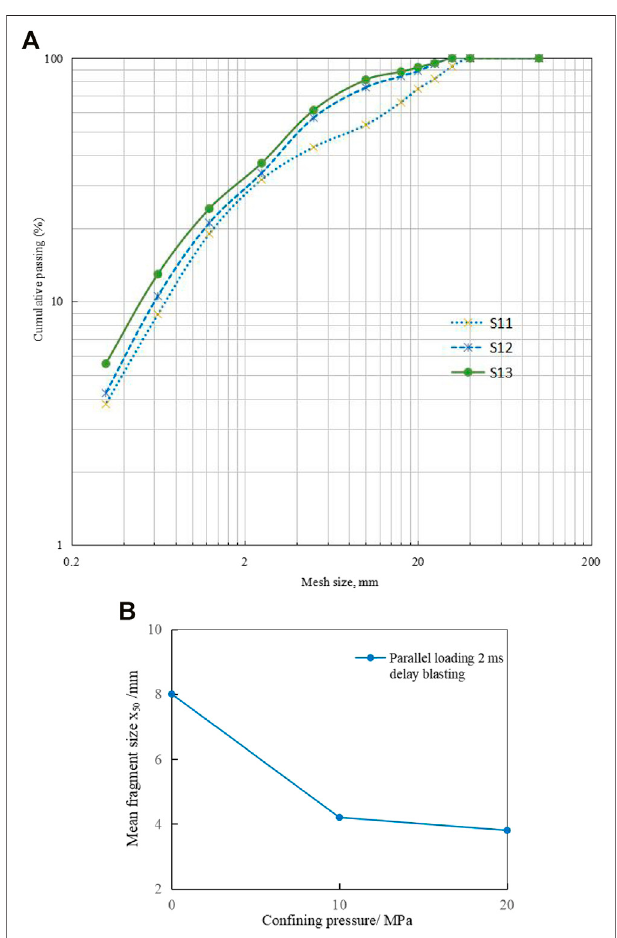
FIGURE 14 | Comparison of blasting fragmentation distribution under 2 ms delay. (A) Blasting fragmentation 274 distribution. (B) Average block size.